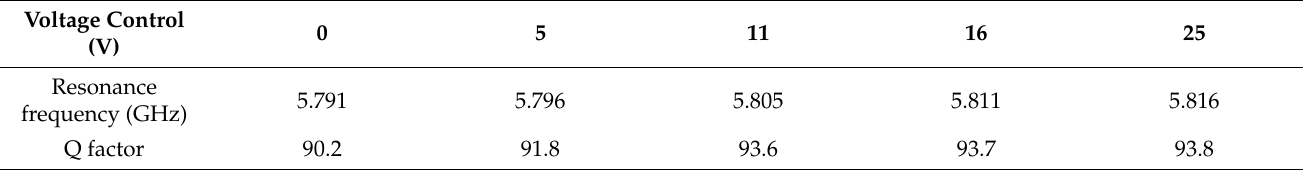
Table 2. Prototype of the measured characteristics versus control voltage.